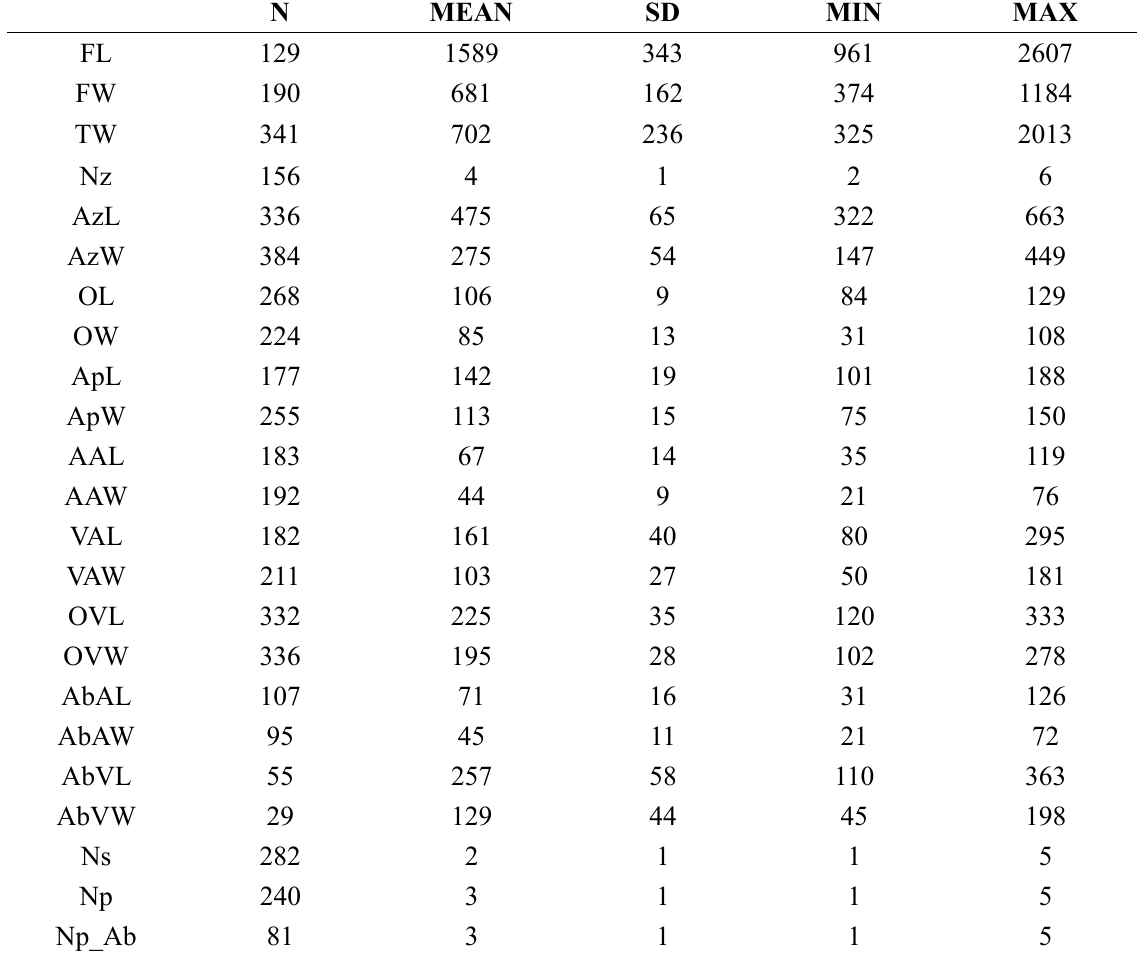
Table 5. Measurements of Schizoretepora pungens (Canu & Bassler,